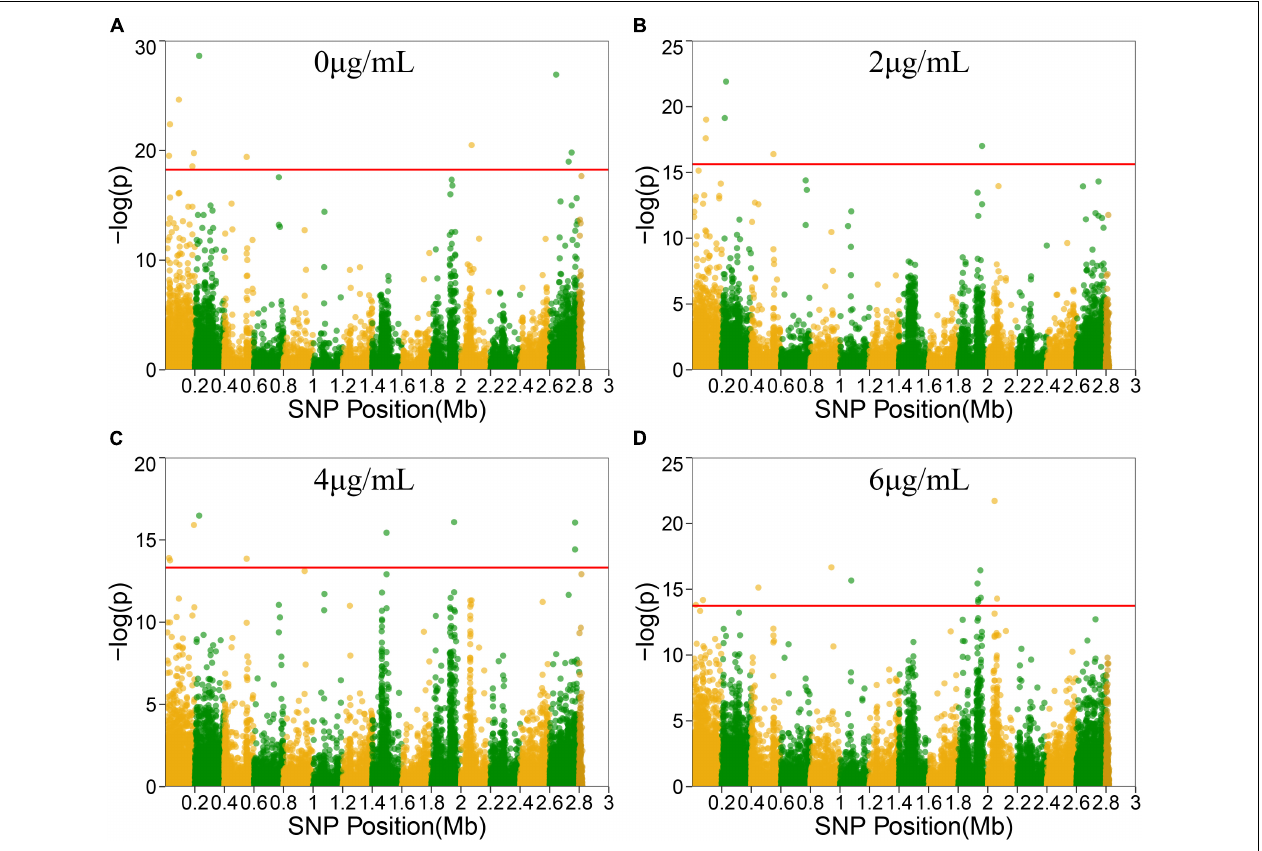
FIGURE 2 | Manhattan plots of functional mapping. Manhattan plot of the significance test based on log-likelihood ratio (LR) for associations between the phenotypic growth differences in different groups and SNPs distributed on the S. aureus genome. SNPs positions in genome were divided by two colors. Each dot in the plot represented an SNP, and a reference line was used on the y -axis to reflect genome-wide significance. (A–D) Represent Manhattan plots of four treatment